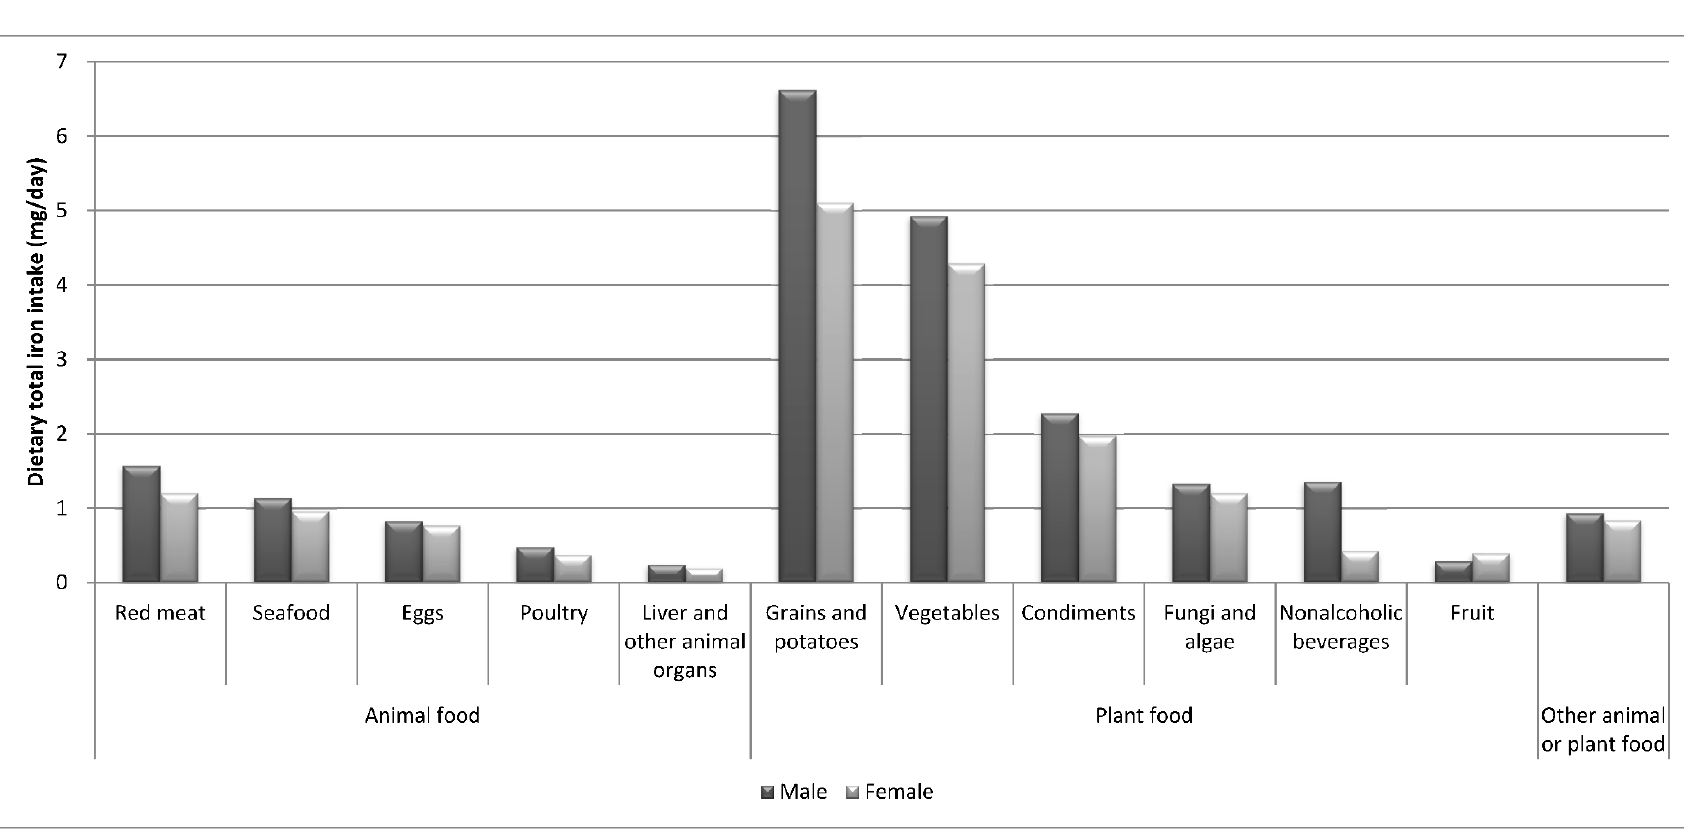
Figure 1. Dietary sources of total iron intake for the different genders in the SDHS 2012–2013.